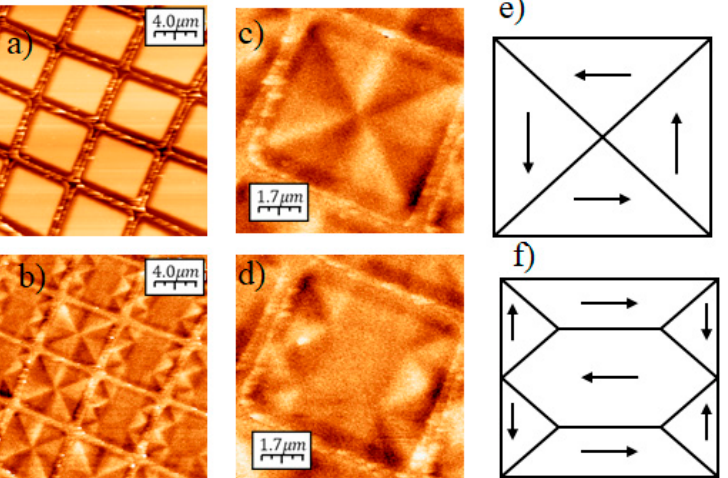
Figure 4. ( a , b ) Topographic and magnetic images, respectively, simultaneously obtained by Magnetic Force Microscopy (MFM), of an array of square 5 μ m edged dots. ( c , d ) Magnetic images of representative square dots exhibiting flux-closure magnetic structures with four and seven domains, respectively. These are the only two flux-closure magnetic structures present in the sample at remanence. ( e , f ) Schematic domain structures deduced from images (c,d), respectively.